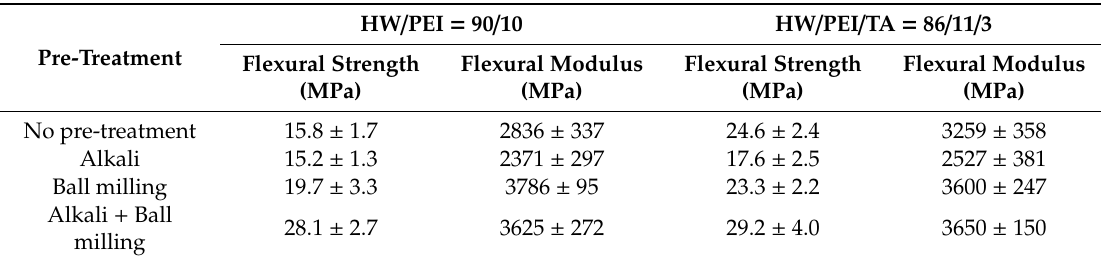
Table 3. Flexural strength and modulus results of ECAP consolidated HW biocomposites with di ff erent